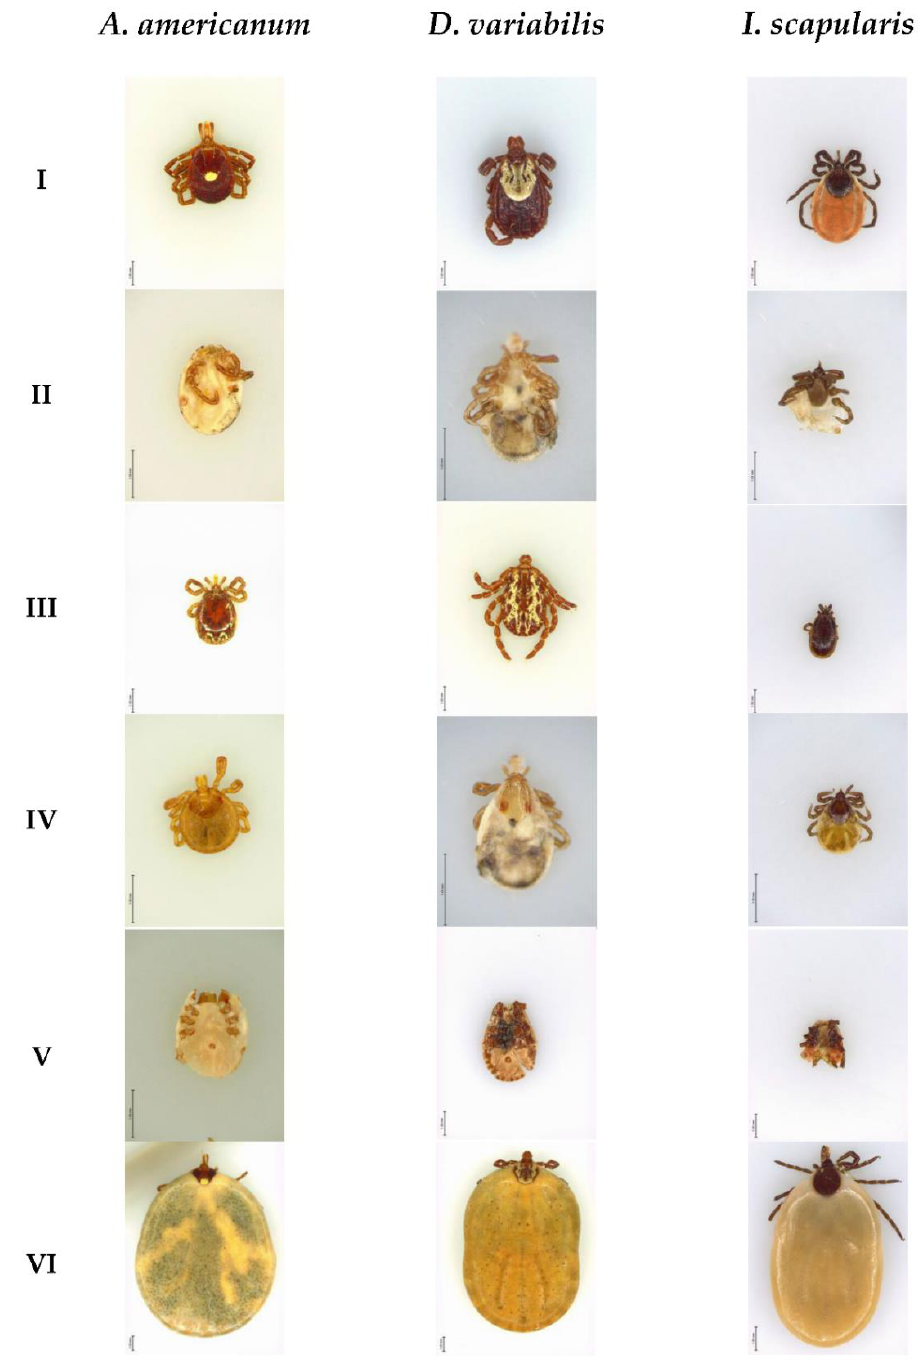
Figure 1. Tick species from the dataset. Inter-species similarity (rows) shows similar traits between different species ( A. americanum , D. variabilis , and I. scapularis ) and intra-species variability (columns) shows differences such as size, color, and developmental stages within the same species. Row I shows adult female ticks; row II shows ventral view of nymph ticks; row III shows male ticks at adult stage; row IV shows dorsal view of nymph ticks; row V shows ticks with missing body parts; and row VI shows engorged adult ticks. Scale bar corresponds to 1 mm.